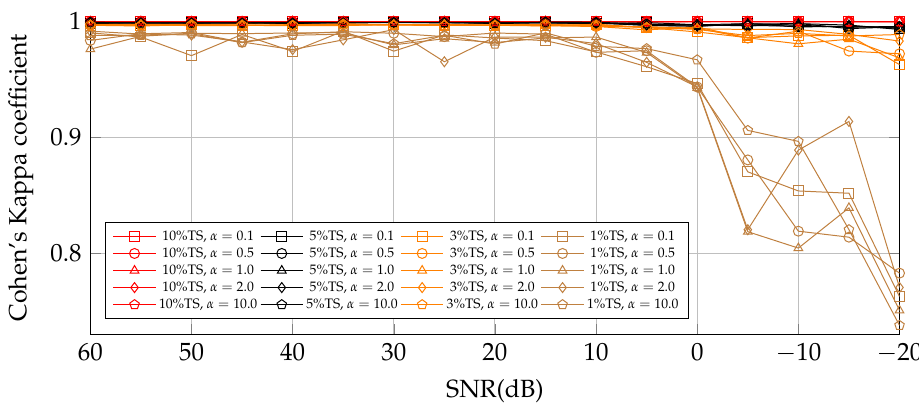
Figure 19. Salinas. Cohen’s Kappa coefficient obtained using 3DCNN DL model trained with 10%, 5%, 3%, and 1% of the samples of compressed SAL HSI for different α values. α -values do not seem to influence Cohen’s Kappa